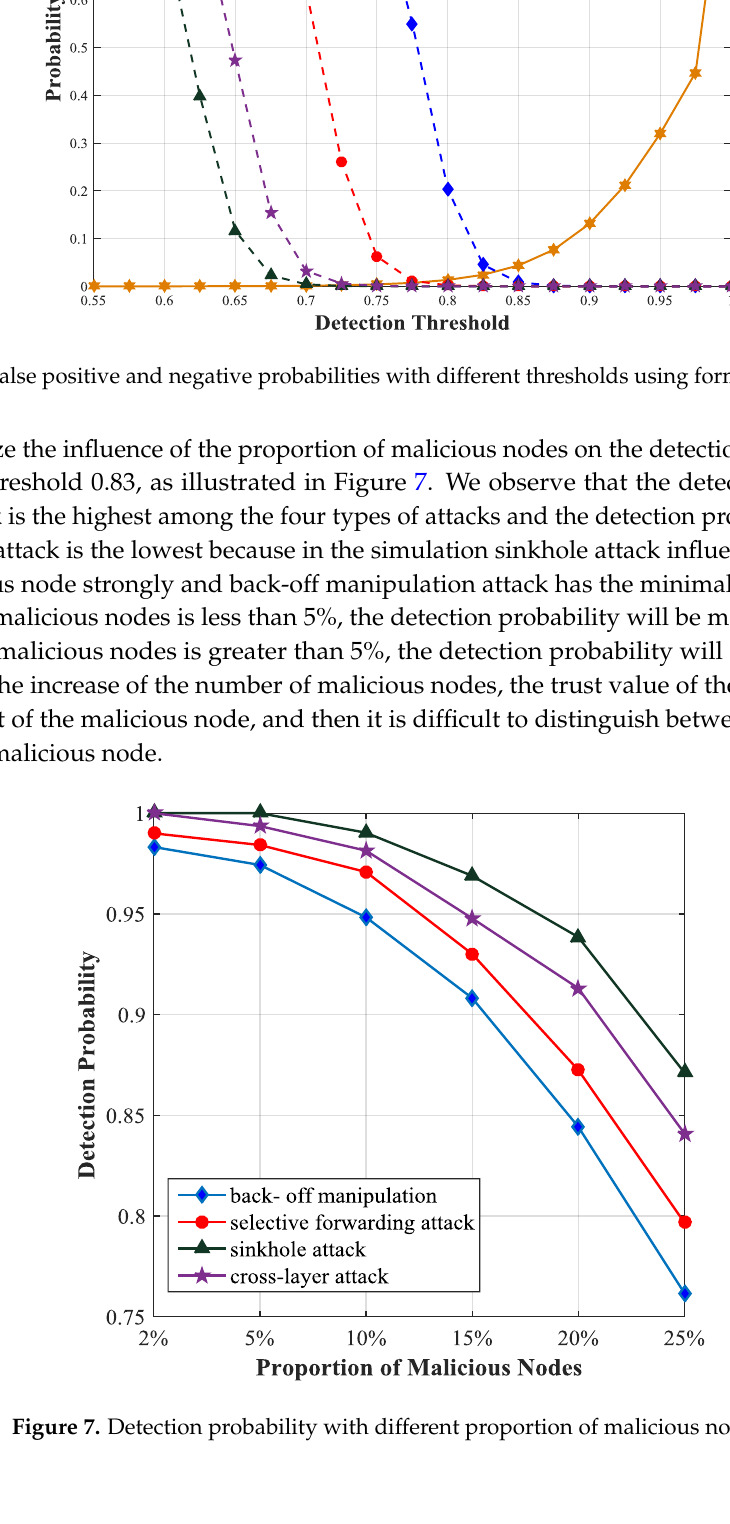
Figure 5. False positive and negative probabilities with different thresholds using simulation .